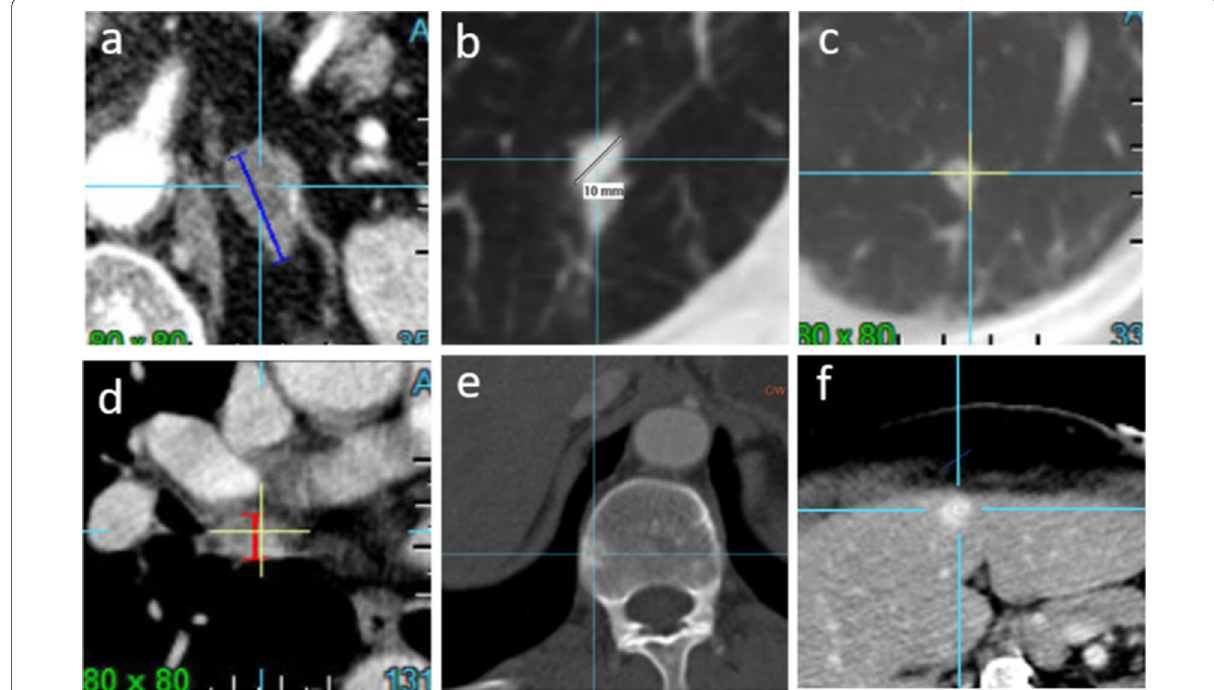
Fig. 1 Views of ambiguous lesions selected at baseline evaluation (derived from RECIST blinded double‑reading central review database). a measurable adrenal nodule believed to be a metastatic lesion from the primary lung cancer (follow‑up: revealed to be a benign incidentaloma); b 10 mm nodule with ground glass in a context of metastatic colon (follow‑up: revealed to be malignant and responded like the rest of the TLs); c non‑measurable well‑defined lung micro‑nodule in a context of head‑neck cancer follow‑up (follow‑up: revealed to be stable and most probably benign); d non‑measurable supra‑centimetric mediastinal lymph node in a context of colon cancer (follow‑up: revealed to be stable supra‑centimetric); e low conspicuity of a blastic bone lesion (follow‑up: revealed to be a metastatic lesion confirmed by sclerotic healing changes); f hypervascular centimetric nodule in the liver in the context of metastatic colon cancer (follow‑up: revealed to be stable and probably unrelated to the